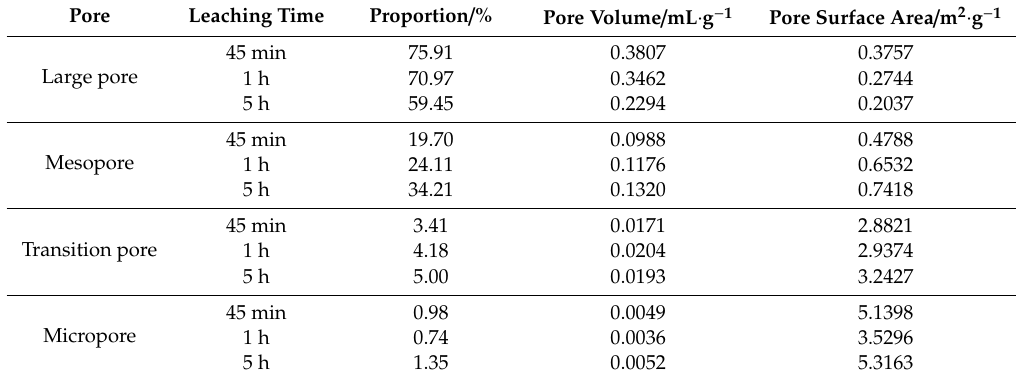
Table 4. Pore characteristics of KLR based on the data of Figure 11.